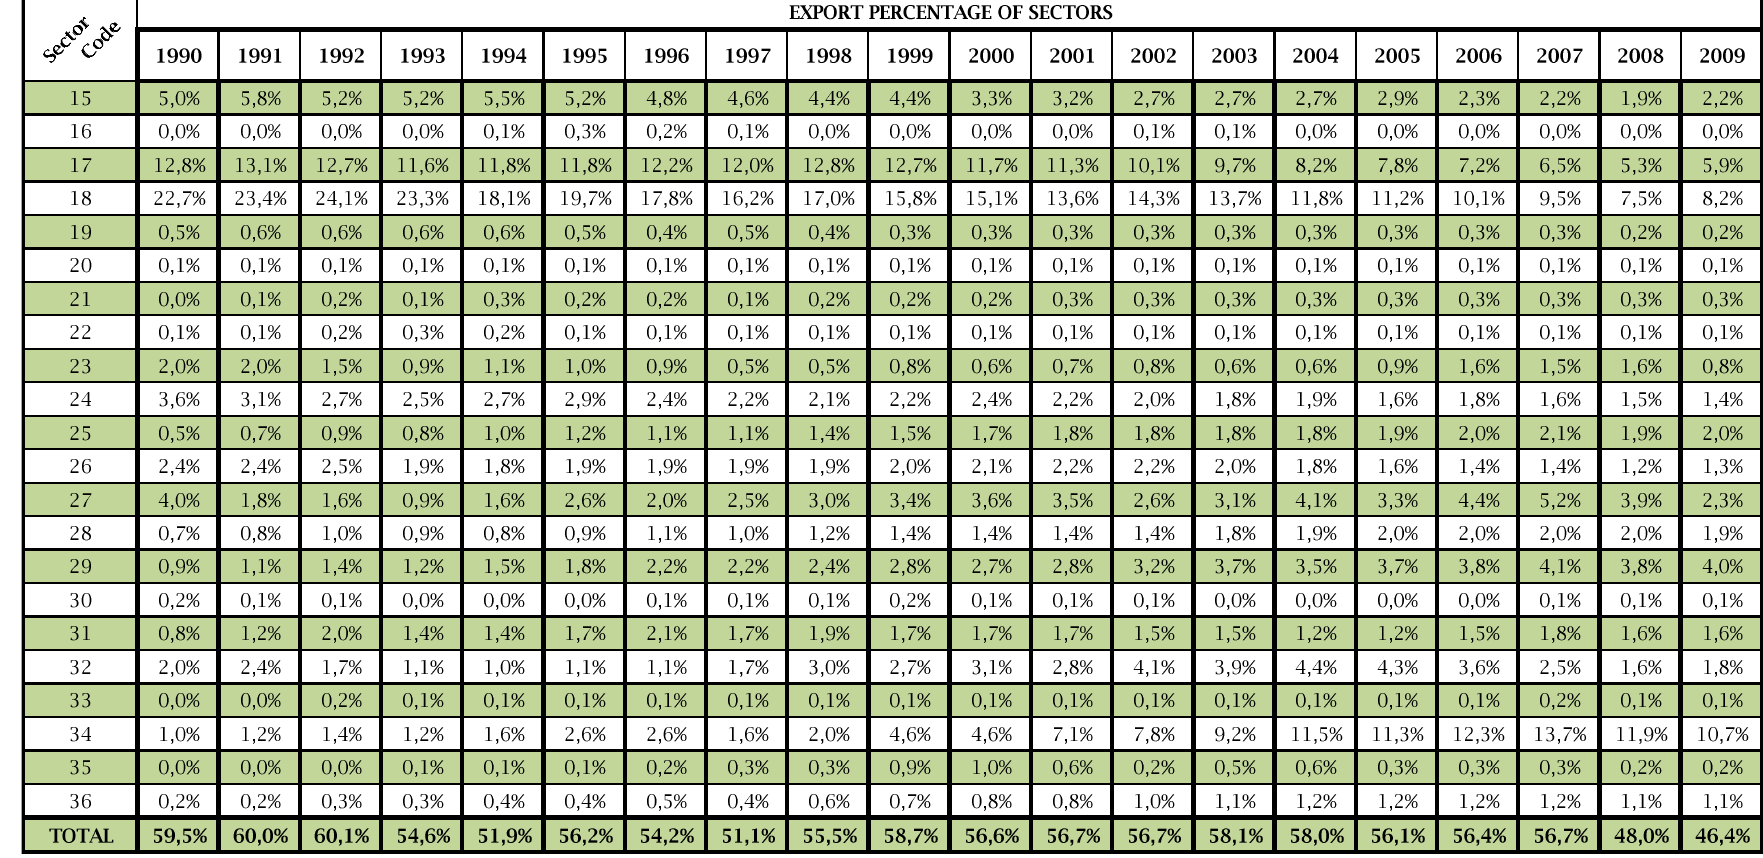
The Effects of EU Customs Union Integration